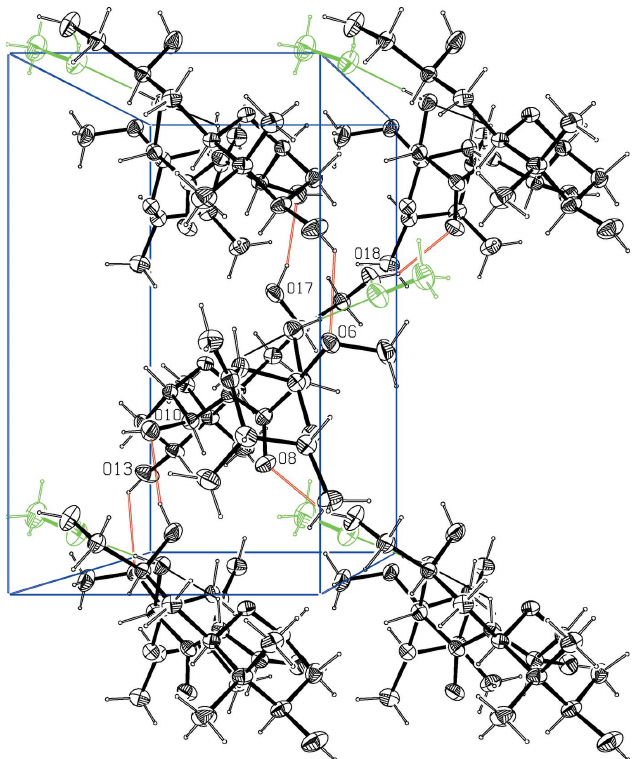
Figure 2 A view normal to the ab plane of the crystal packing of the title compound. The methanol solvent molecules are shown in green and the hydrogen bonds as thin red lines (see Table